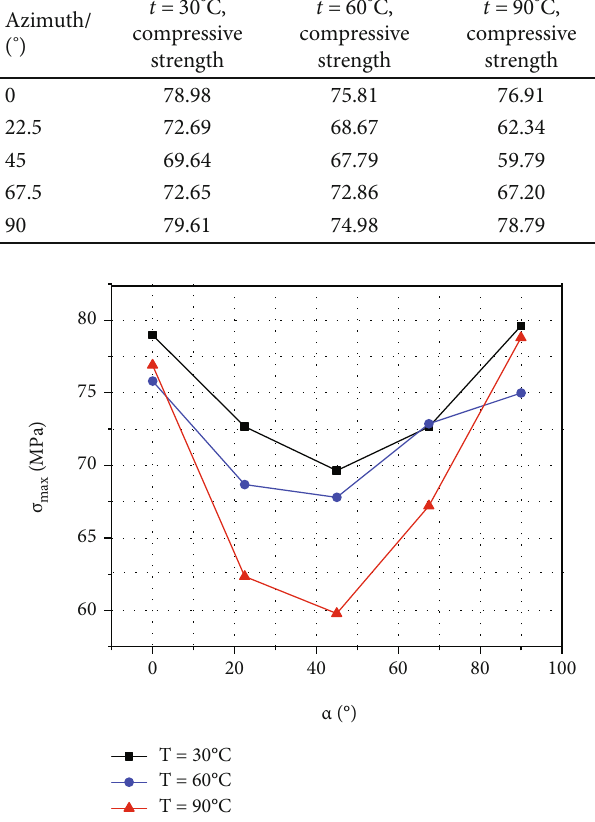
Figure 7: Variation law of the shale bedding e ff ect at di ff erent temperatures and di ff erent dip angles.